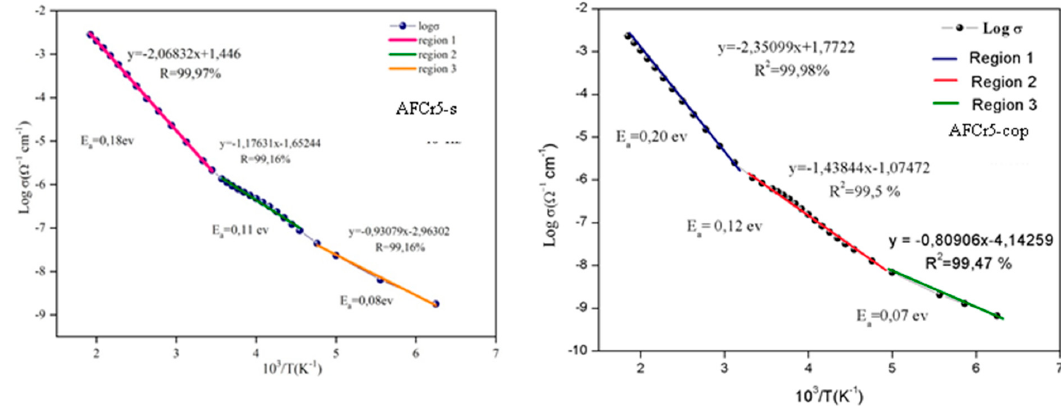
Figure 10. Variation of log ac conductivity with inverse of the absolute temperature for selected frequencies for AFCr5-s and AFCr5-cop.